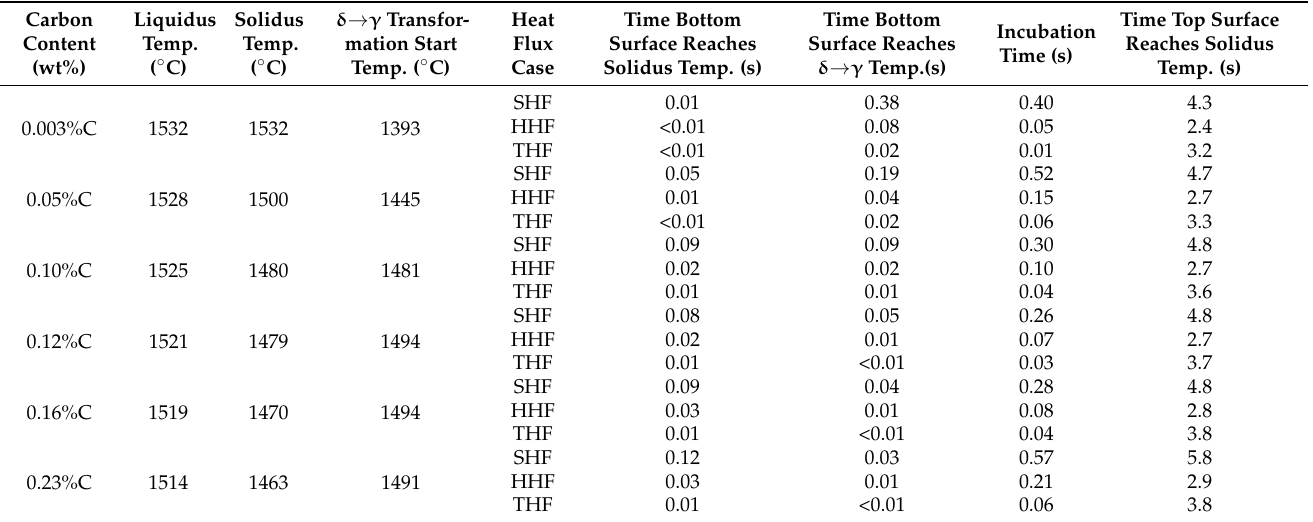
Table 1. Phase transition temperatures and times when droplet surfaces reach these temperatures for six investigated steels at different cooling conditions.